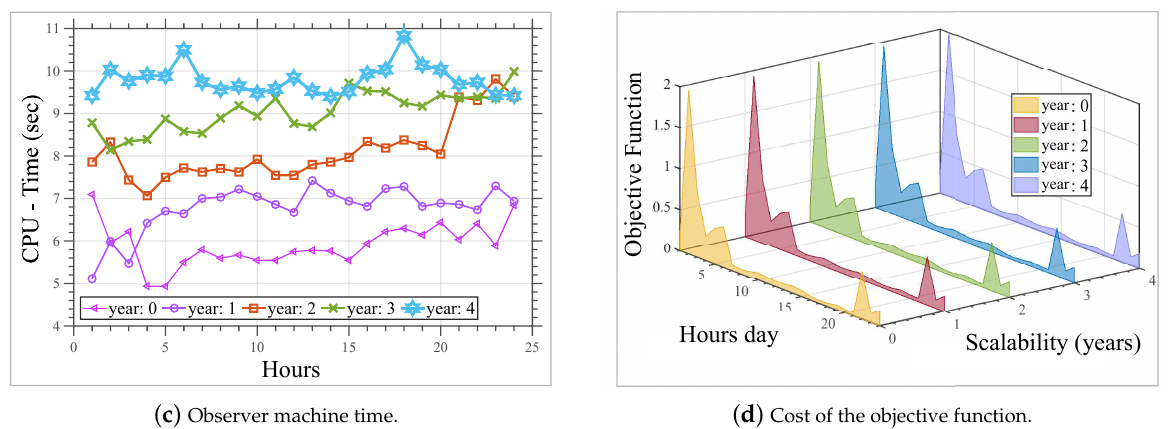
( d ) Cost of the objective function.